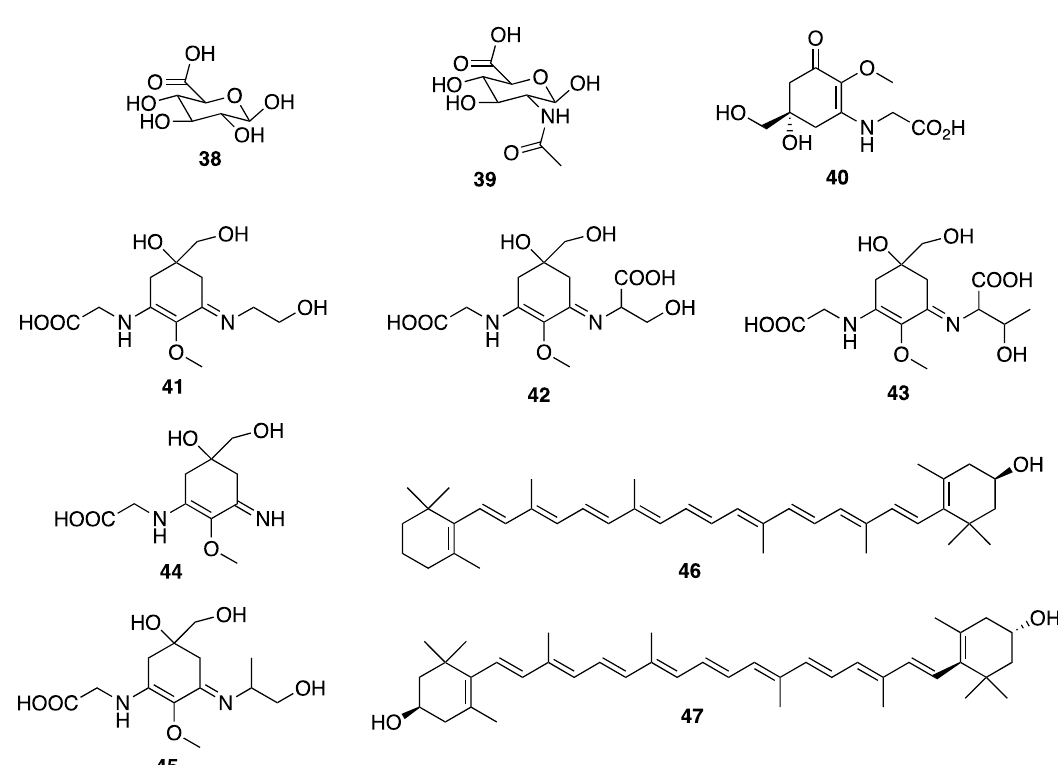
Figure 7. Structures of β - d -glucuronic acid ( 38 ), N -acetyl- β - d -glucosamine ( 39 ), mycosporine-glycine ( 40 ), asterina-330 ( 41 ), shinorine ( 42 ), porphyra-334 ( 43 ), palythine ( 44 ), palythinol ( 45 ), β -cryptoxanthin ( 46 ), and xanthophyll ( 47 )